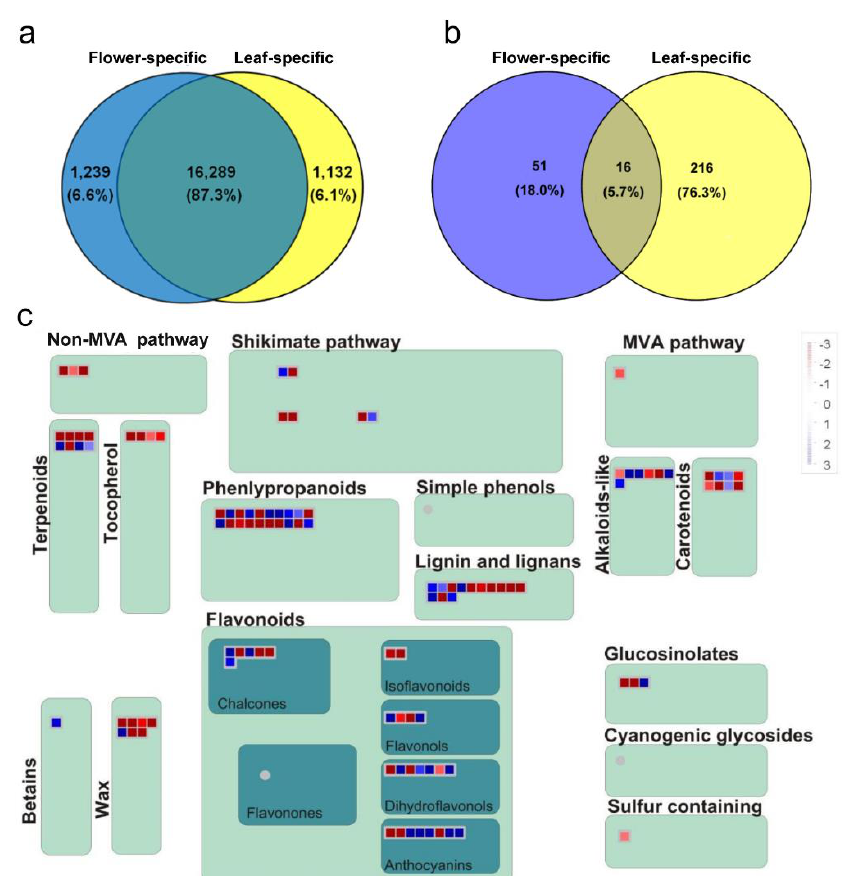
Figure 3. Venn diagram indicating the number of differentially expressed transcripts ( a ) and its corresponding GO-enrichment ( b ) in both flowers and leaves. MapMan regulation overview map ( c ) showing transcript level differences in secondary metabolism of leaves and combined flowers. In color scale, blue represents lower transcript level in flowers, while red represents higher transcript level in comparison with leaves. Note: MVA pathway is an abbreviation for the mevalonate pathway.